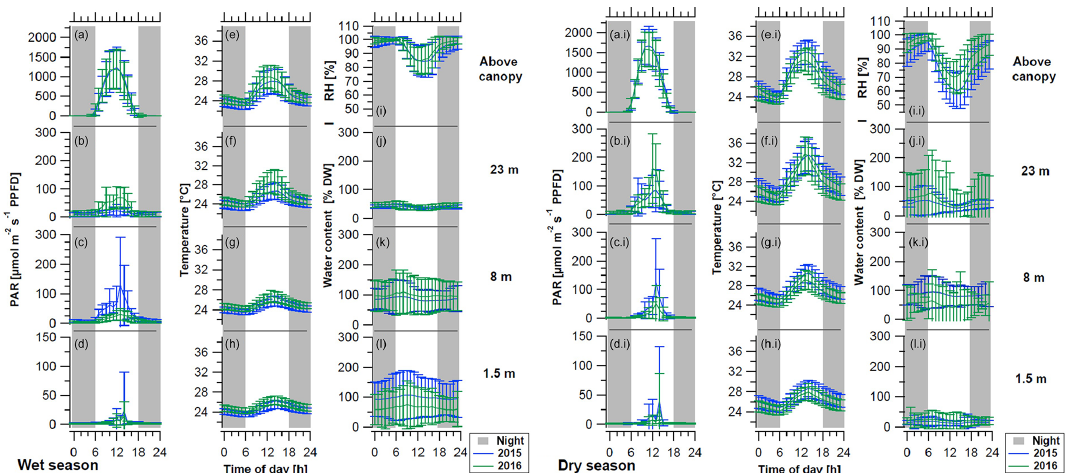
Figure 3. Mean diurnal cycles of light conditions (PAR), temperature, and water content (WC) of bryophytes and above-canopy meteorolog- ical parameters during (left) the wet season and (right) dry season of the years 2015 (blue lines) and 2016 (green lines). The above-canopy meteorological parameters comprise (a, a i ) the photosynthetically active radiation (PAR at 75m), (e, e i ) the temperature (at 26m), and (i, i i ) the relative air humidity (RH at 26m height). The micrometeorological parameters measured on top and within epiphytic cryptogamic communities comprise (b–d, b i –d i ) the photosynthetically active radiation (PAR) on top, (f–h, f i –h i ) the temperature within, and (j–l, j i –l i ) the WC of cryptogamic communities at different height levels. Diel cycles were calculated from 30min intervals of the whole seasons and show hourly mean values ± SD. Data of the sensors installed at the same height level were pooled, while the above-canopy parameters were measured with one sensor each. Nighttime is shaded in gray